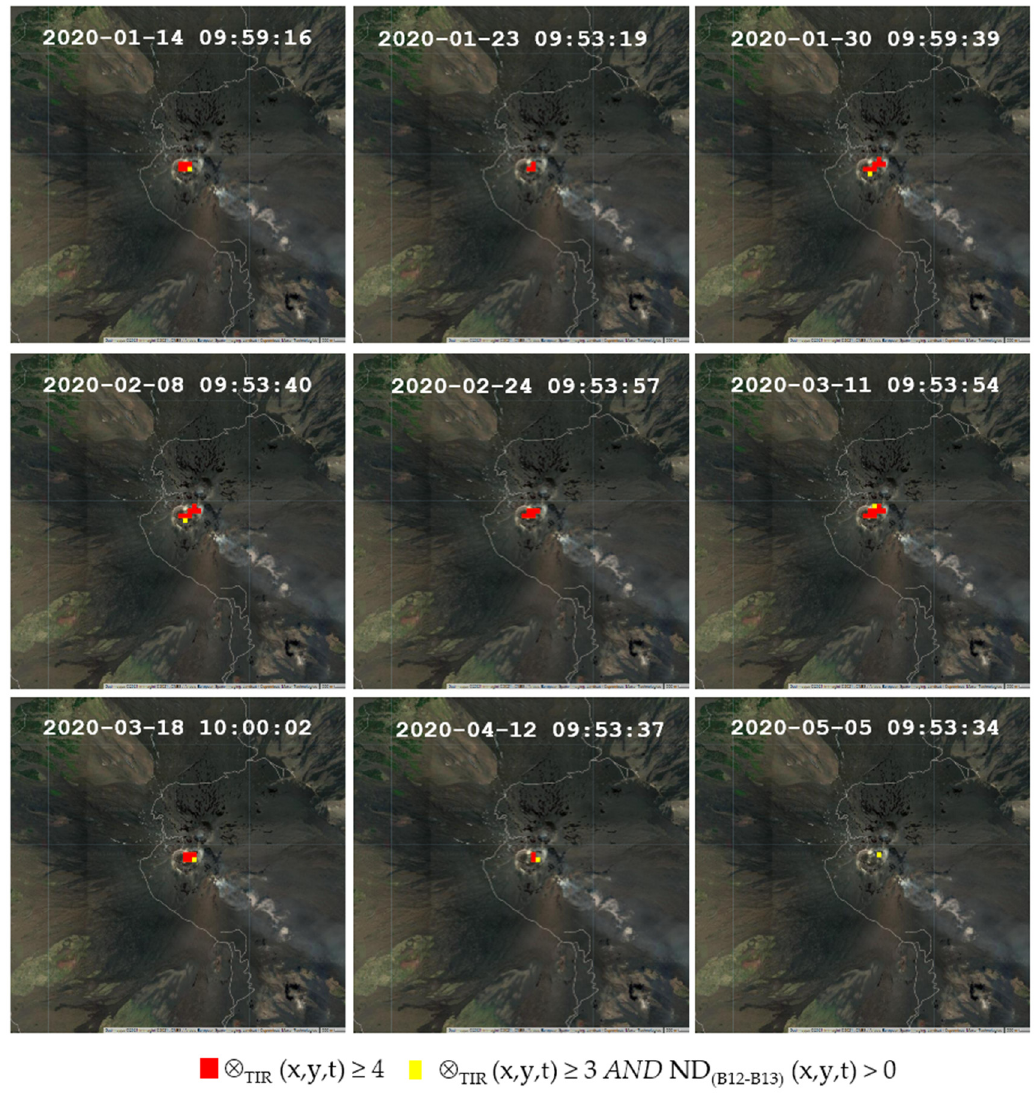
Figure 4. Thermal anomalies detected by RASTer at Mt. Etna during the period January–May 2020, associated with the Strombolian activity recorded at the Voragine-Bocca Nuova